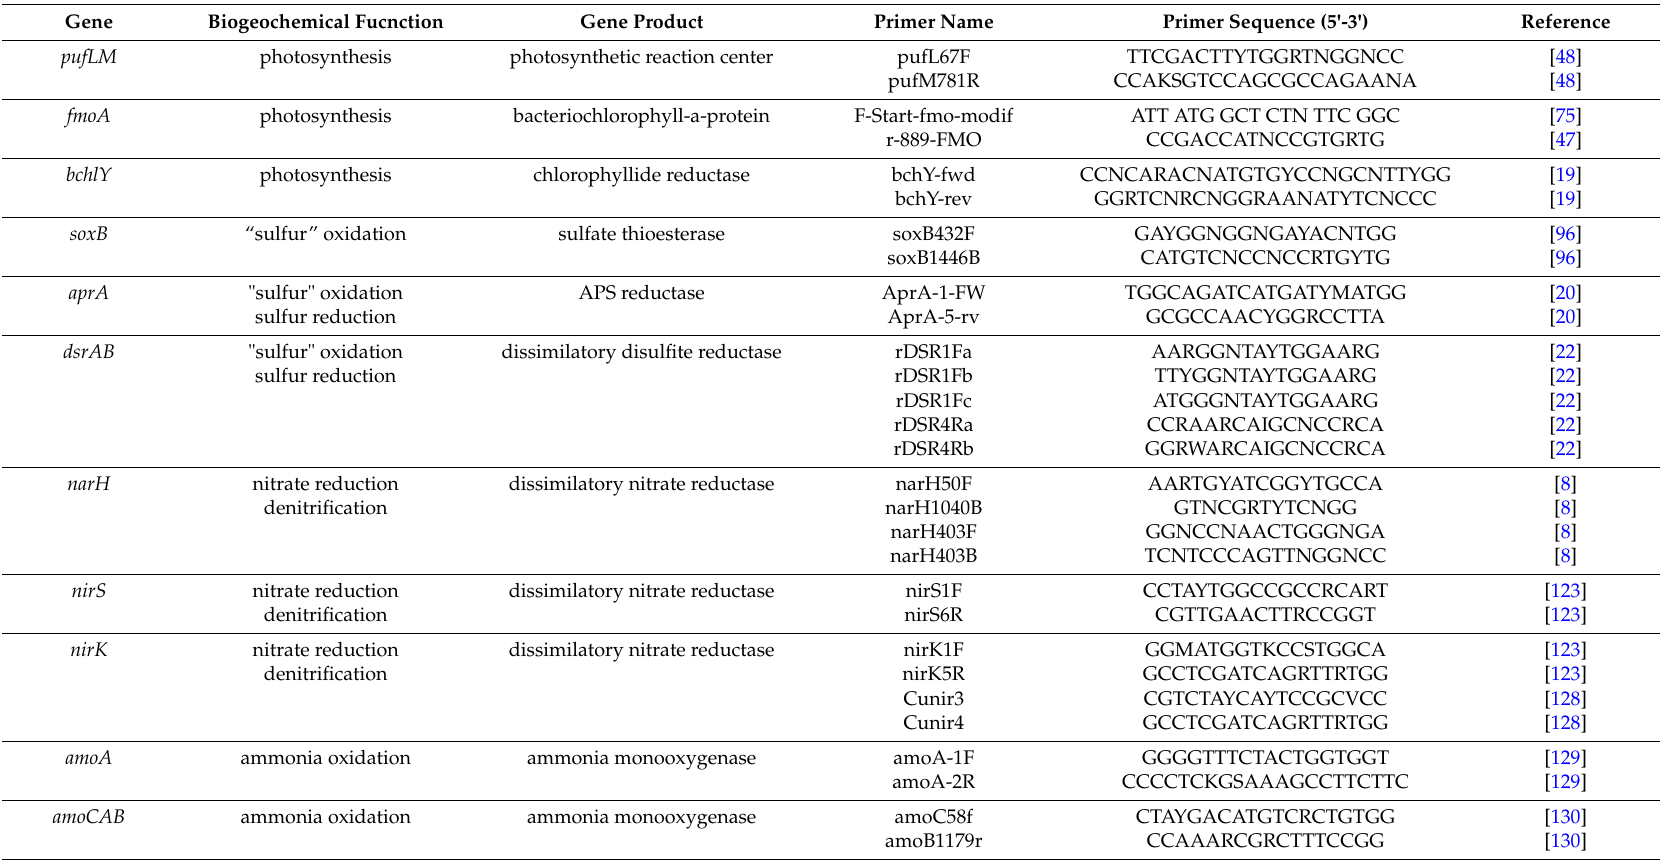
Table 1. Selected primers for functional gene